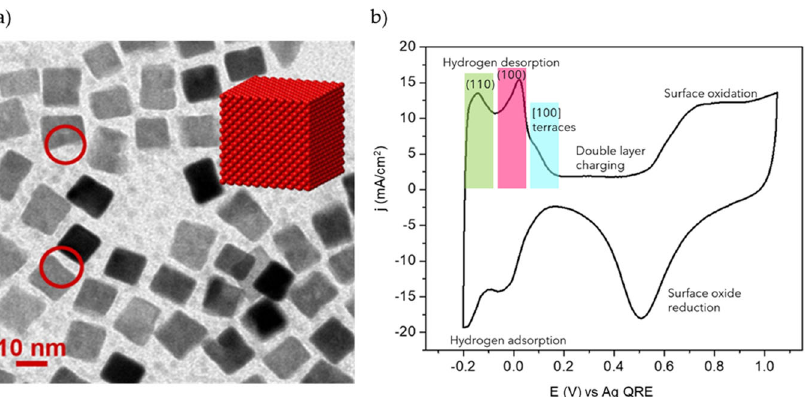
Fig. 2 Transmission electron microscopy (TEM) and cyclic voltammetry (CV) of platinum nanocubes prepared by water-in-oil microemulsion in the 25% HCl in the aqueous phase. a TEM and b CV. (Panel a with JACS permission 2